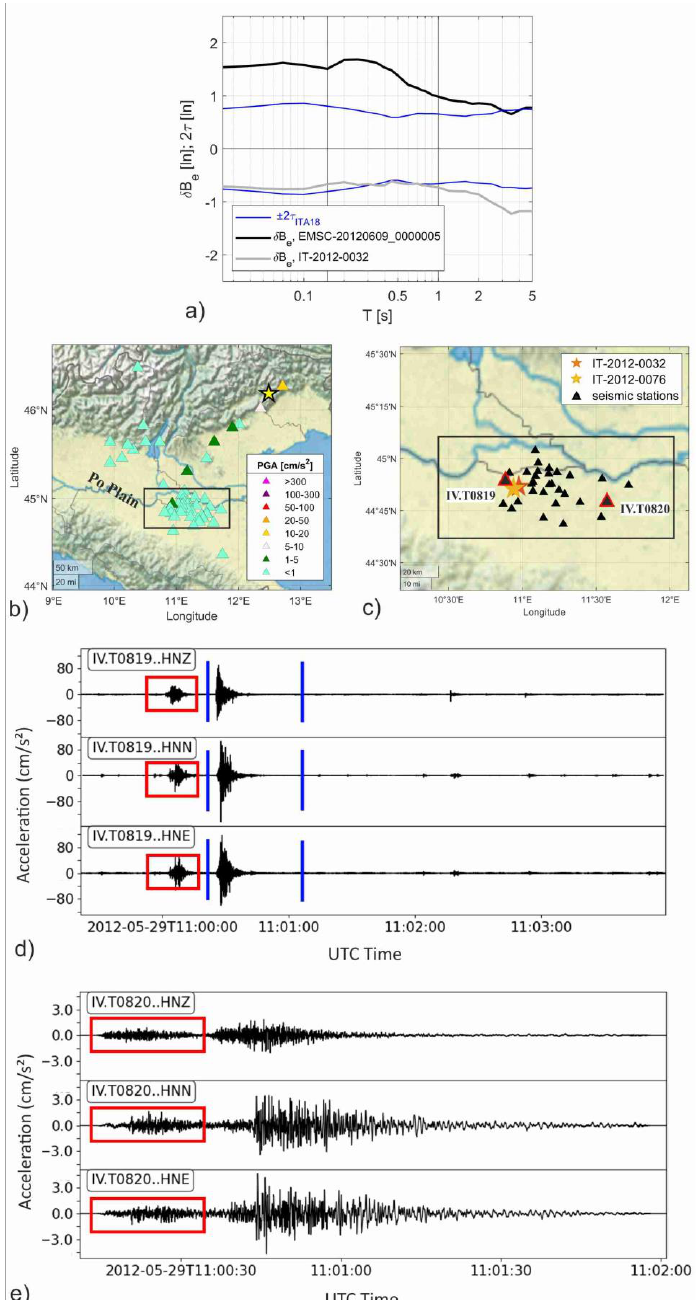
Figure 6. ( a ) examples of peculiar δB 𝑒 residuals; ( b ) spatial distribution of the epicenter (star) and recordings (triangles) for the event EMSC-20120609_0000005. The colors represent the Peak Ground Acceleration (PGA) at each station. The black box indicates the epicentral area of the 2012 Emilia seismic sequence. ( c ) Spatial distribution of the epicenters related to the IT-2012-0032 and IT-2012-0076 events. The recording stations highlighted in red are those whose accelerometric time series are reported in panels ( d ) (raw traces) and ( e ) (processed traces). The red box indicates the IT-2012-0076 event in the pre-signal noise of IT-2012-0032, whereas the blue lines delimitates the trimmed